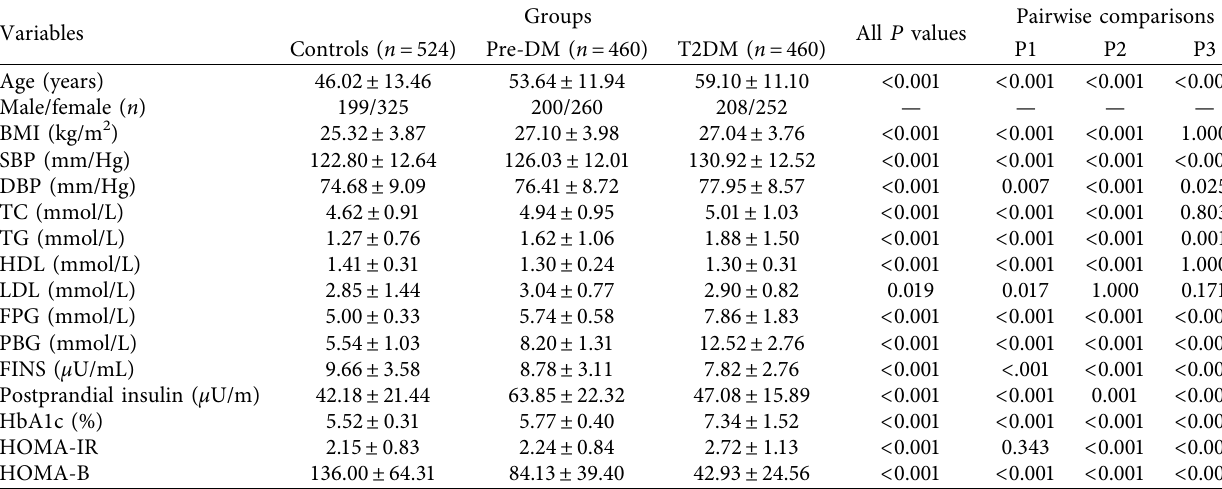
Table 1: Demographic and biochemical characteristics of participants in the healthy control, pre - DM, and T2DM patient groups. Variables